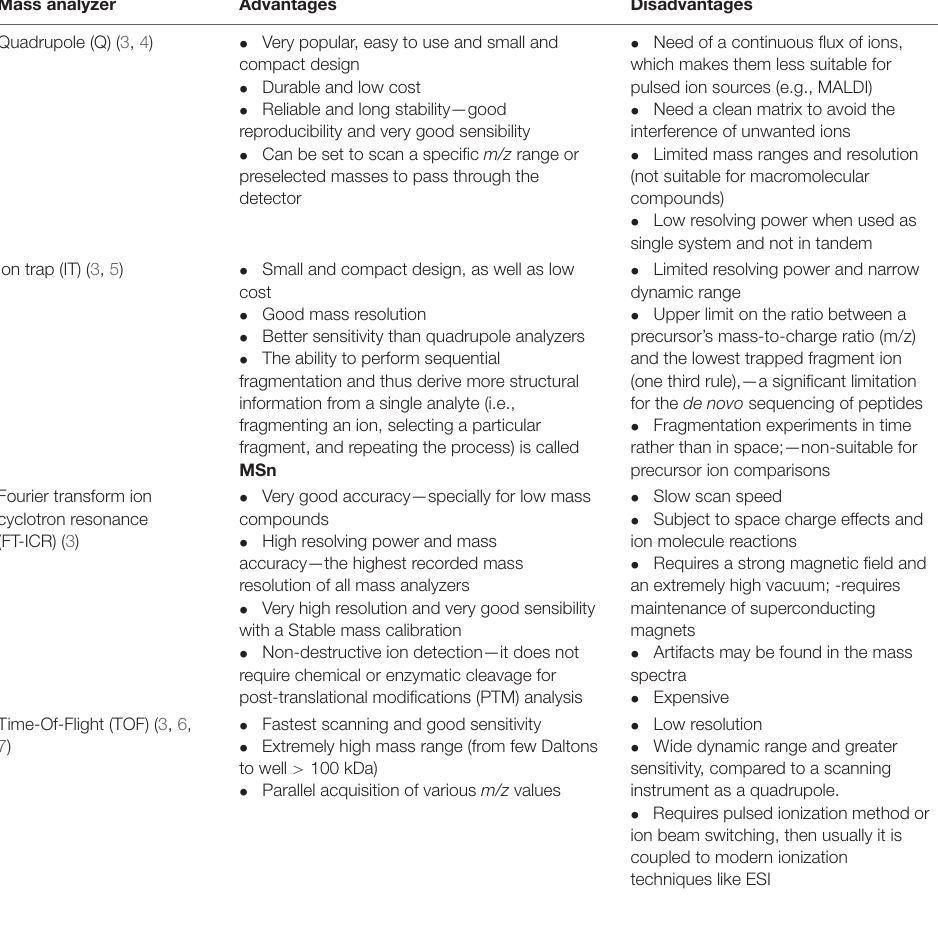
TABLE 1 | Description of main mass analyzers used in the field. Mass analyzer Advantages Disadvantages